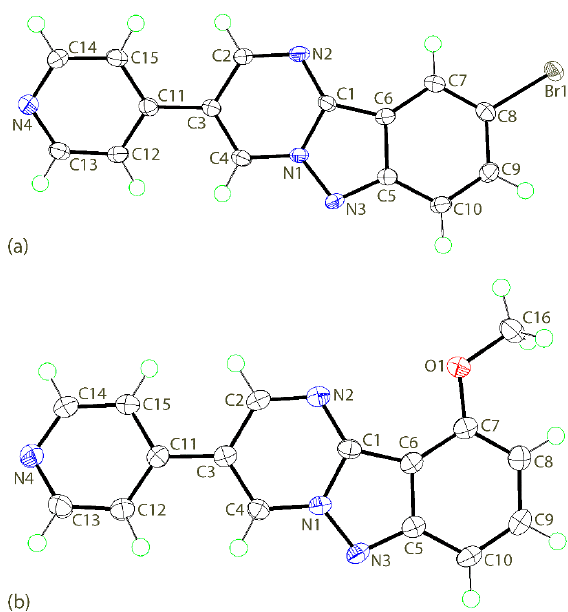
Figure 1. The molecular structures of: ( a ) 1b; and ( b ) 1c showing atom labelling schemes and aniso- tropic displacement parameters at the 70% probability level.